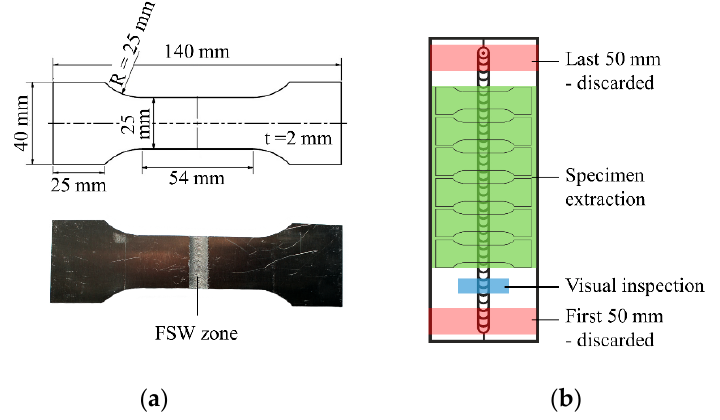
Figure 4. ( a ) Specimen geometry and ( b ) extraction position of the milled specimens.